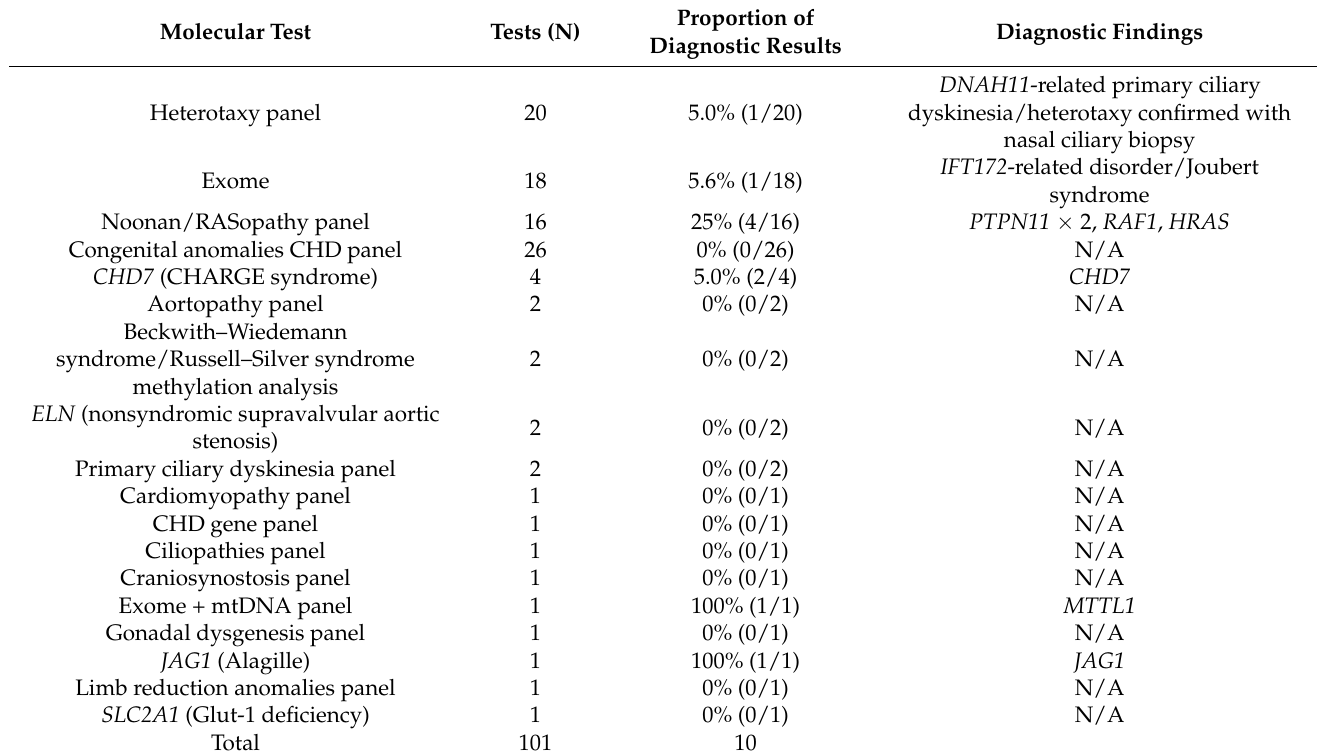
Table 5. Molecular testing